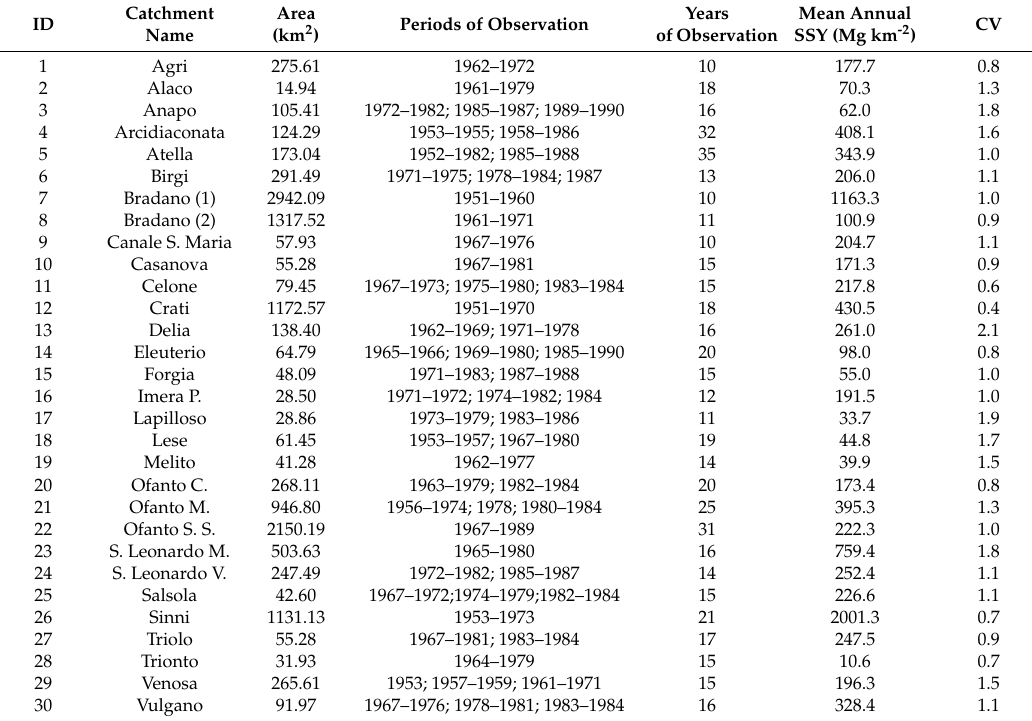
Table 1. List of catchments and specific sediment yield (SSY) data with reference periods. CV is the coefficient of variation or relative standard deviation of mean annual